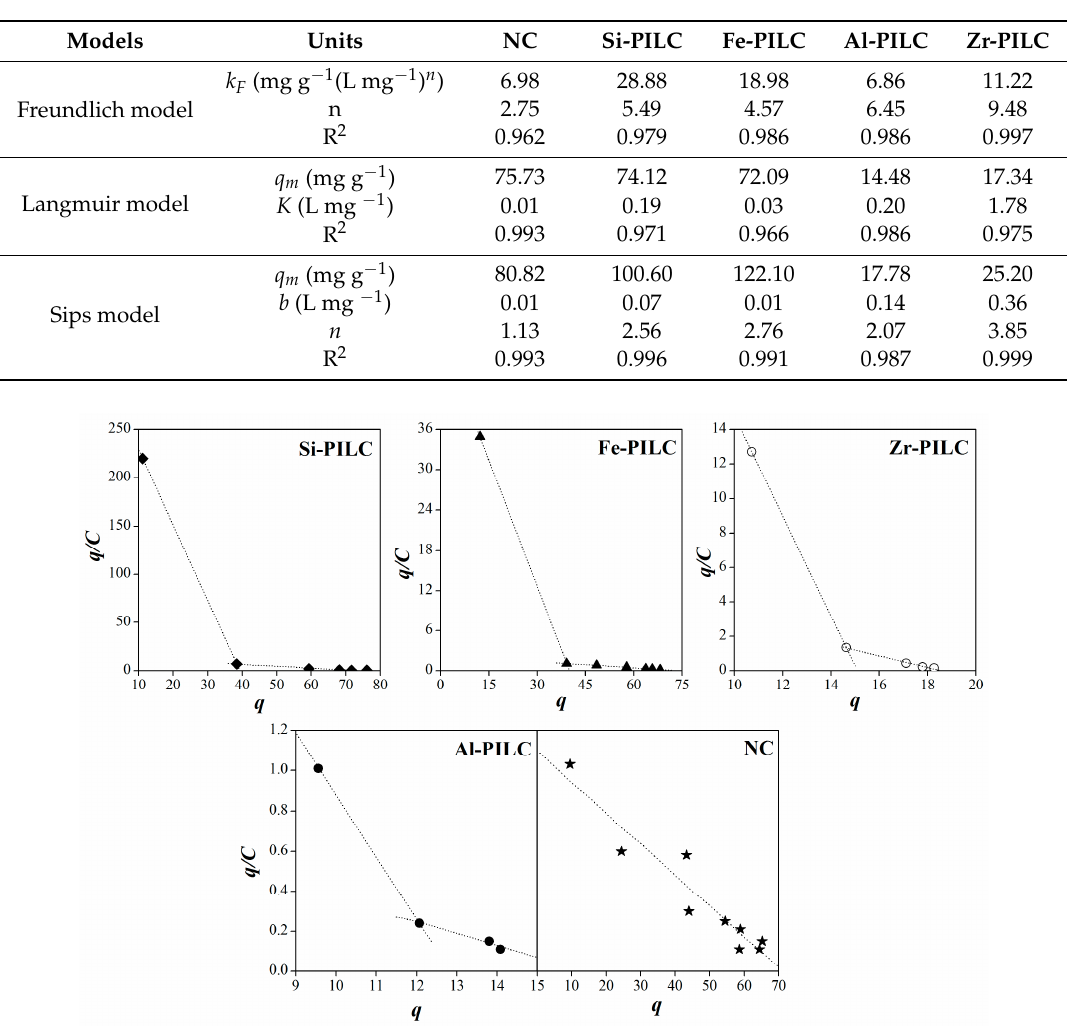
Figure 6. Scatchard plots derived for adsorption data obtained at pH 10 for the five materials.